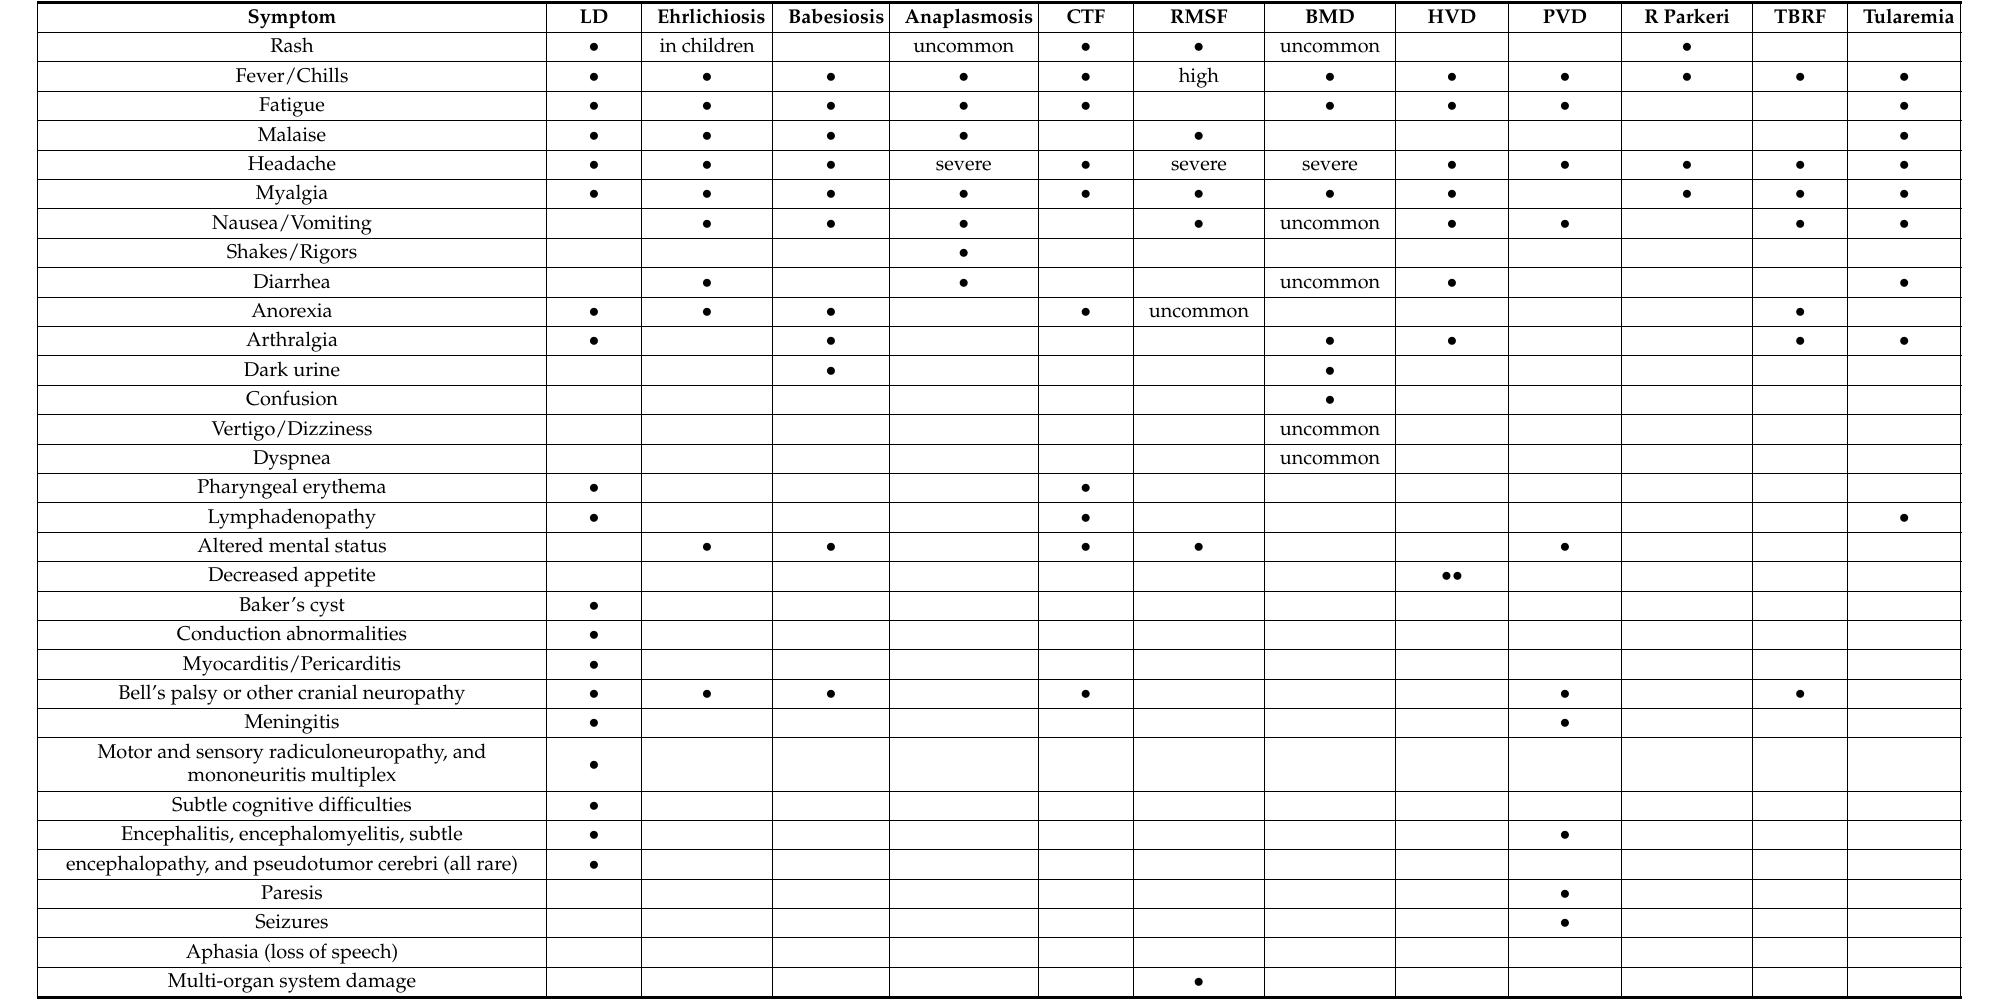
Table 16. CDC Tickborne Diseases of the United States: A Reference Manual for Healthcare Providers (2018). Summary of all TBD Symptoms.